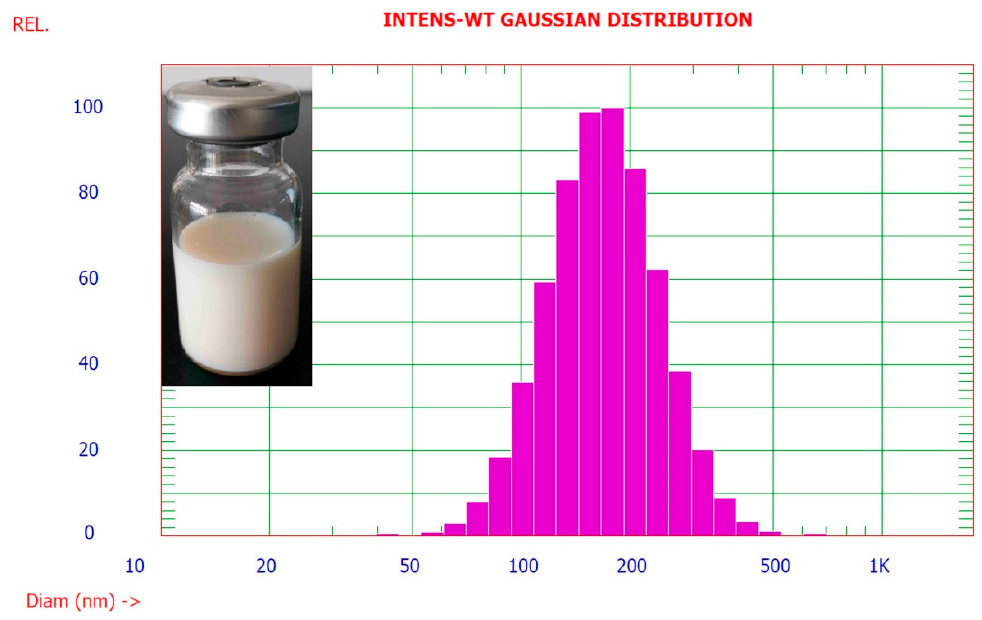
Figure 6. Photo of HME and its particle size distribution determined by the PSS NICOMP Particle Size System.